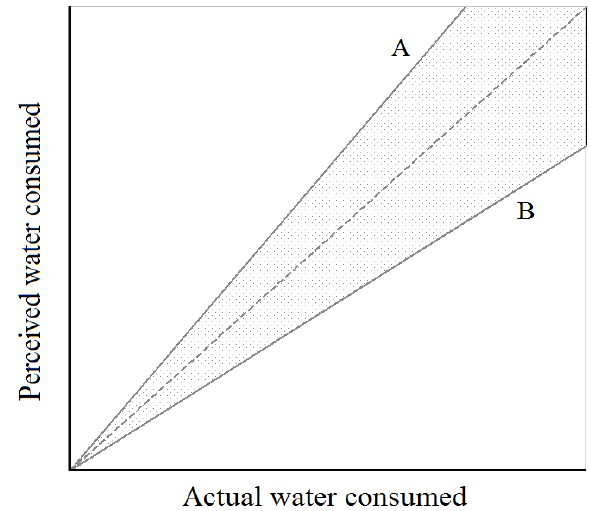
Figure 3. Division of overestimation, accurate estimation and underestimation of water consumption